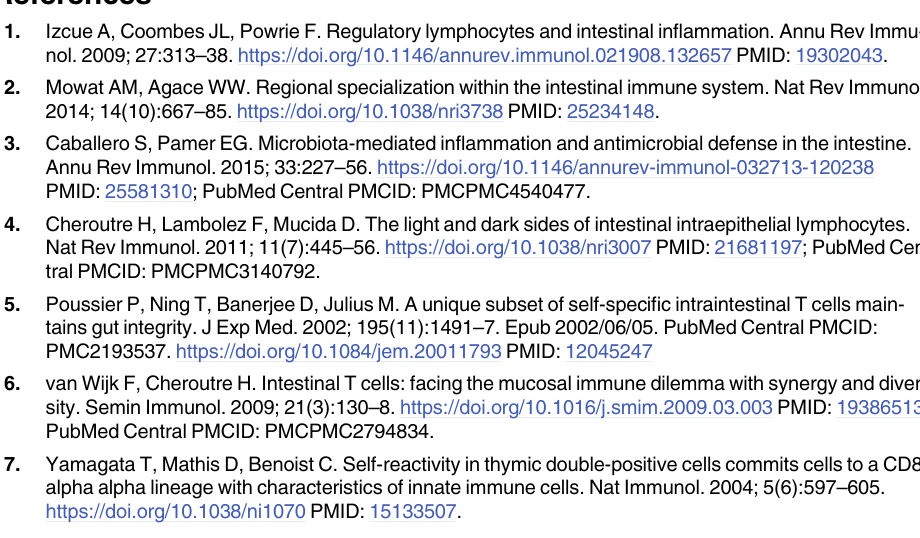
figure are representative of three independent experiments. Erk, extracellular signal–regulated kinase; IEL, intraepithelial lymphocyte; p-Erk, phosphorylated Erk; Rbpj, recombination signal binding protein for immunoglobulin kappa J region. S1 Methods. A description of methods performed to achieve IELs culture and colitis induc- tion. IEL, intraepithelial lymphocyte. S1 Data. Data underlying Figs 1–6, S2 Fig, S4 Fig and S5